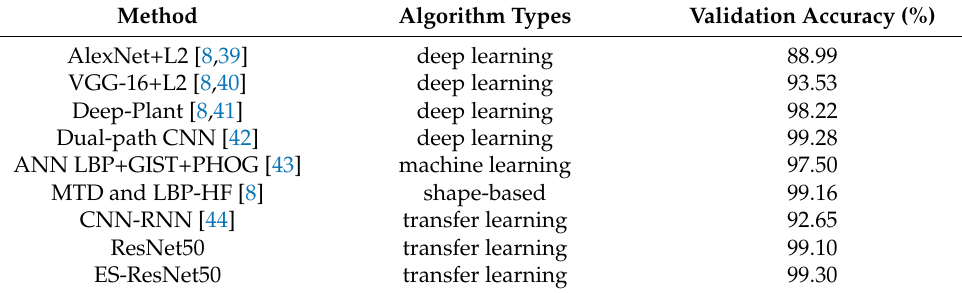
Figure 19. Sample images of the Swedish leaf dataset, one image per class. Table 7. Comparison with other methods on the Swedish leaf dataset. Table 6. Comparison with other methods on the Flavia leaf